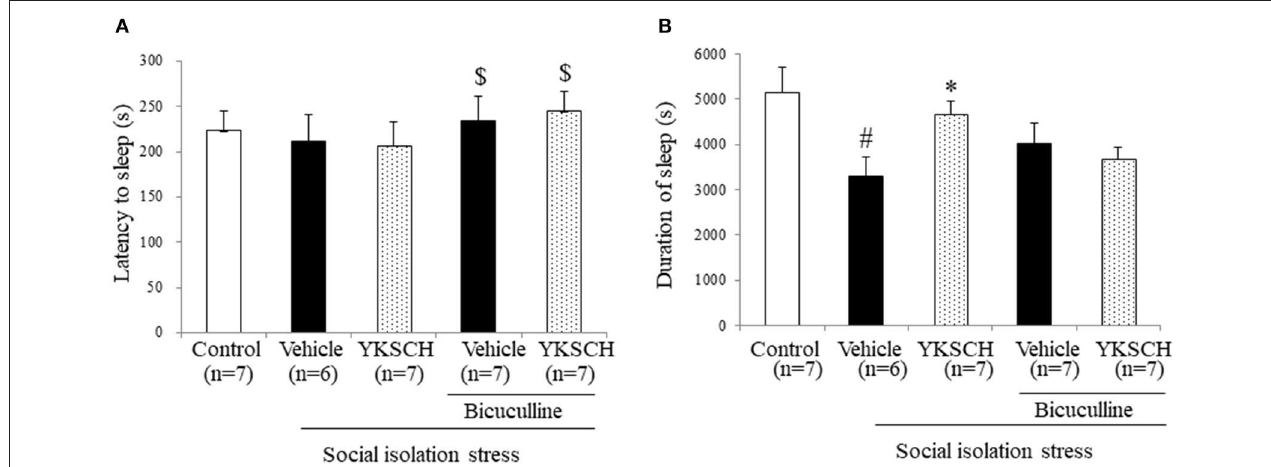
FIGURE 5 | Effect of YKSCH was mediated by GABAergic neuron system in socially isolated mice. Mice were housed individually and treated with YKSCH or vehicle for 4 weeks. Thirty minutes after the last injection, mice were treated with 3 mg/kg bicuculline (i.p.). Mice were treated with 60 mg/kg pentobarbital 30min after bicuculline injection. The sleep latency (A) and duration (B) were measured. Diazepam was administered once 1h before pentobarbital injection. Data are expressed as the mean ± SEM ( n = 6–7). # p < 0.05 vs. the control group; * p < 0.05, vs. the vehicle-treated group; $ p < 0.05, vs. the YKSCH-treated group, Peritz’s F -test.